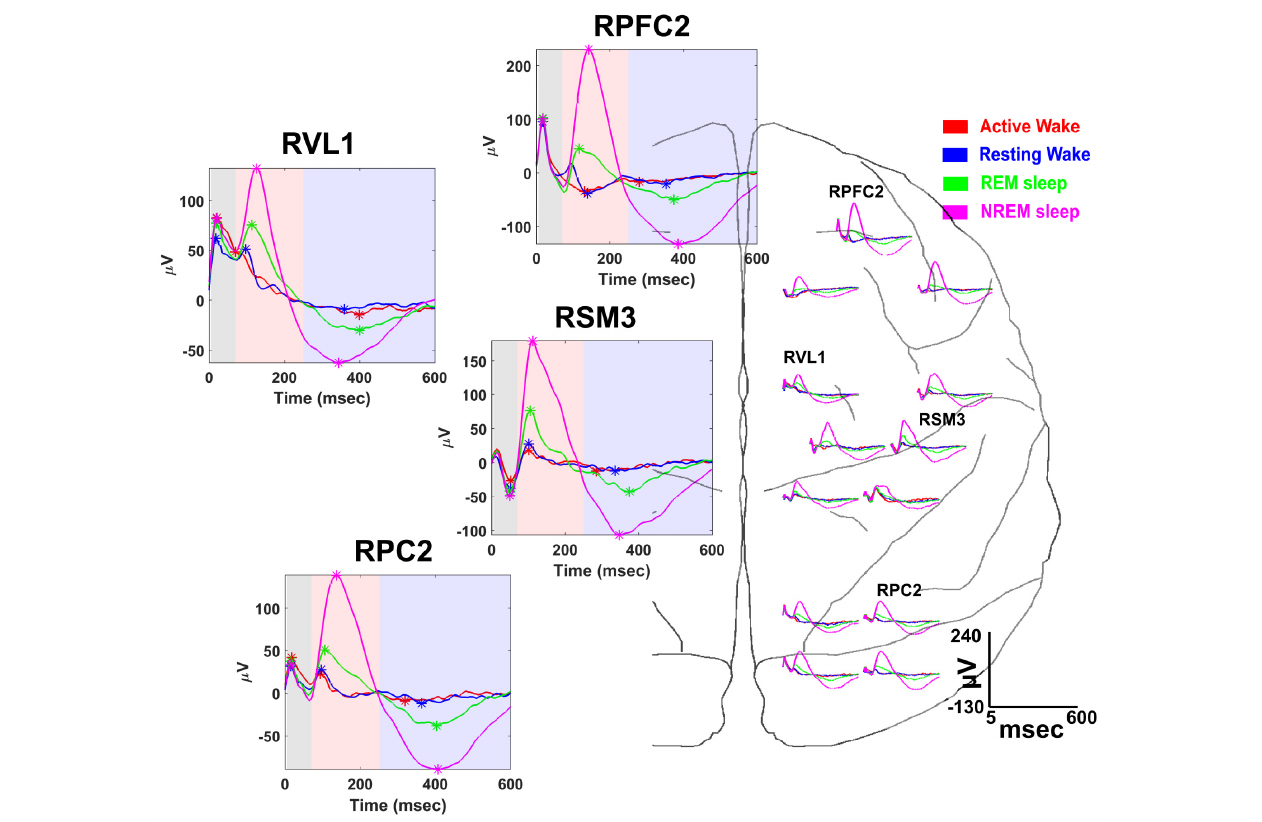
FIGURE 9 | Vagal evoked potentials (VEPs) elicited during different behavioral states: (active-wake AW, red); resting-wake (RW, blue); rapid eye movement sleep (REM, green); and non-REM sleep (NREM, magenta). Representative averaged evoked potentials recorded from the following cortical sites are expanded at left: right prefrontal cortex (RPFC2), right ventrolateral nucleus of thalamus (RVL1), right somatosensory-motor cortex (RSM3), and right parietal cortex (RPC2). Time is measured from the first pulse of the 300 Hz train of 5 pulses delivered to the vagus nerve; colored areas designate the time range for specific VEP components (from Rembado et al.,